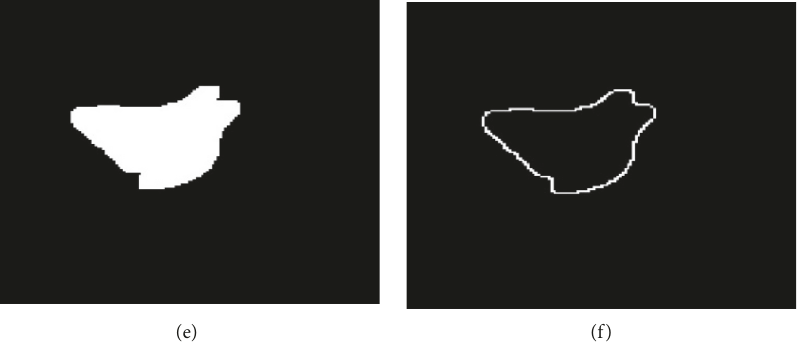
Figure 5: Results of various stages of the image processing algorithm indicating (a) actual grayscale image and images (b–f) obtained after thresholding, filtering, dilation, erosion, and edge detection, respectively. Table 1: Details of the machining parameters. Workpiece outer